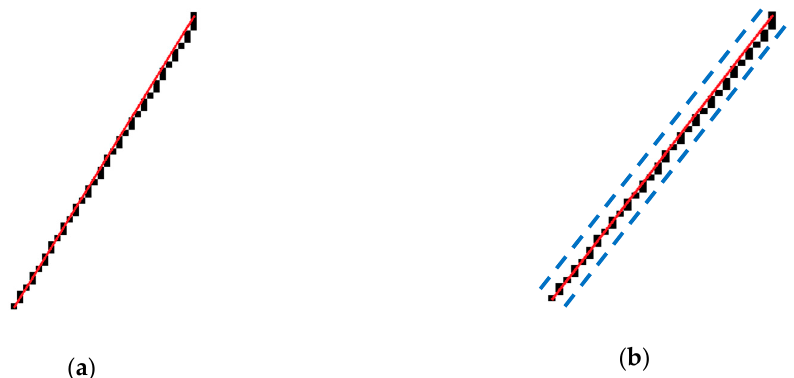
Figure 2. Illustrations of line detection technique: ( a ) Example of a not-perfectly-straight line after 1-pixel pre-processing; ( b ) neighborhood points considered in the line detection process.